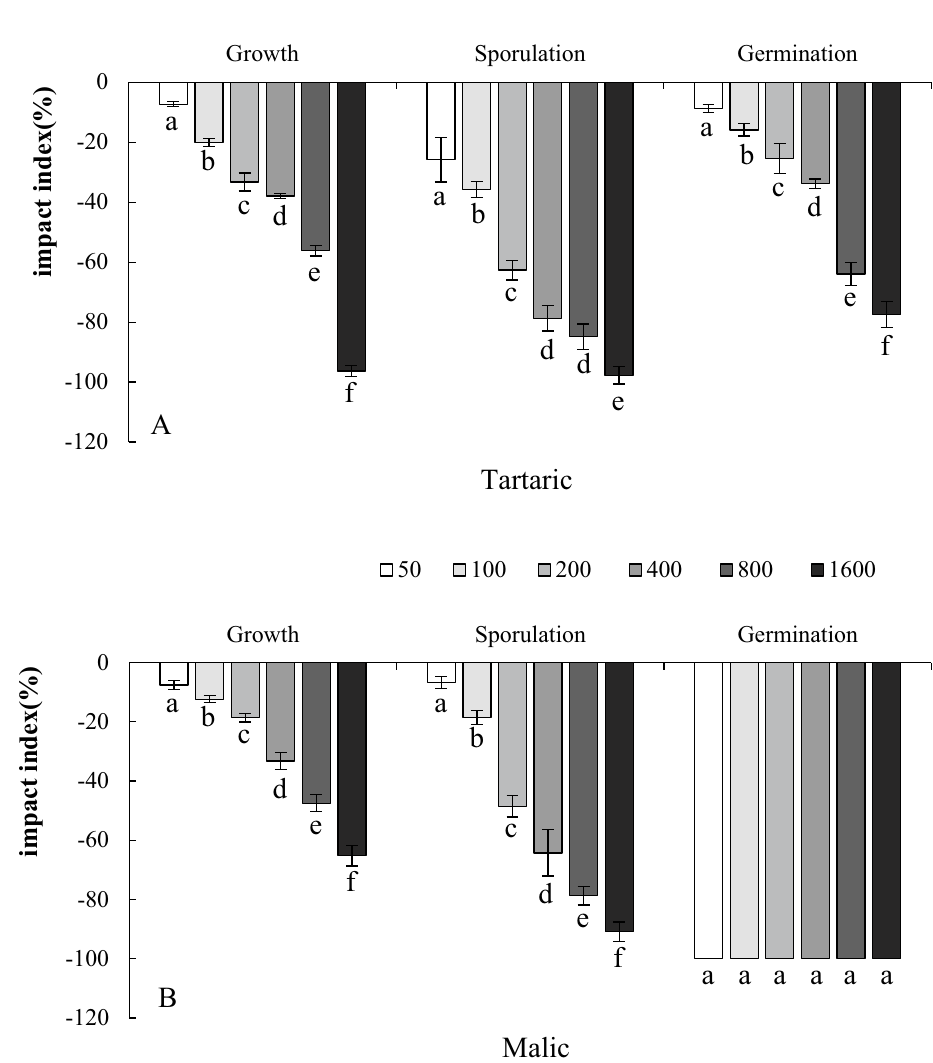
Figure 2. Effect of different concentrations of organic acids on the mycelial growth, sporulation and spore germination of FOF. Tartaric (A), Malic (B). All the values are presented as the mean ± SE. The different letters on the mean values of the same index indicate significant differences among the treatments ( P <